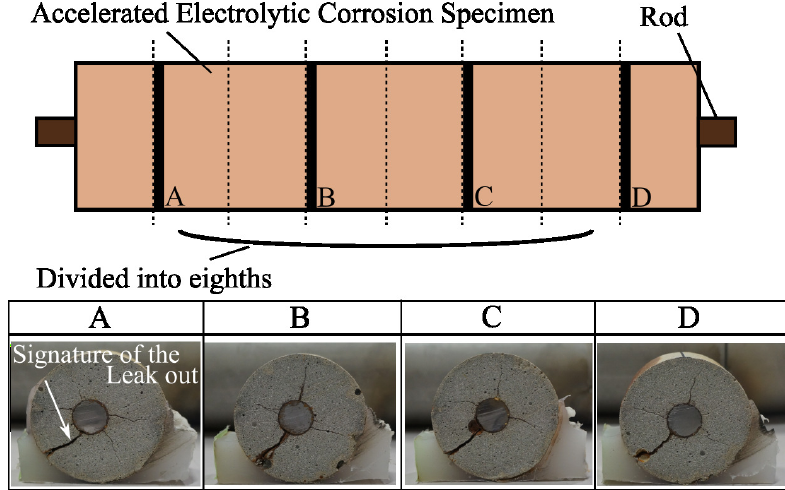
Figure 10. Cross-sectional view of the accelerated electrolytic corrosion specimen after 60